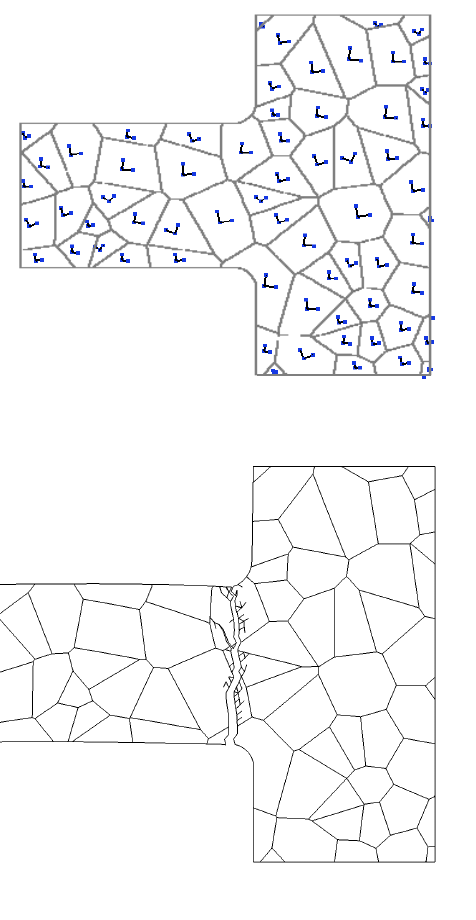
Figure 5. Micro-structure A, perfect GB case ( 5.2 crystal morphology on MEMS failure. (top) local orientations of the in-plane axes of elastic symmetry, and (bottom) relevant crack patterns at